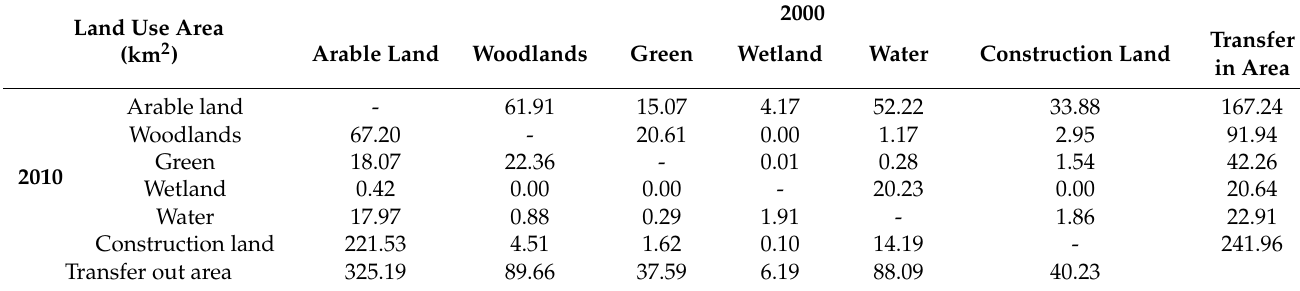
Table 6. Transfer matrix of land use in main districts from 2000 to 2010.